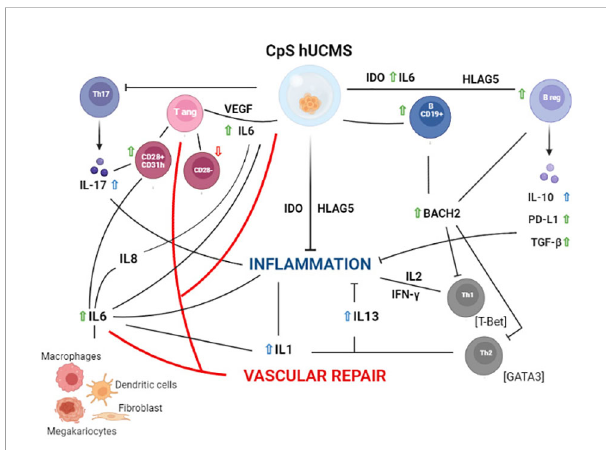
FIGURE 6 Schematic representation of the hypothetical mechanisms of action of PBMC from Sjogren patients after 5 days of culture with CpS- hUCMS. Green arrows indicate an increase in the presence of CpS- hUCMS; red arrows indicate a decrease in the presence of CpS- hUCMS; whereas arrows in blue indicates an increase in the presence of both CpS-hUCMS and